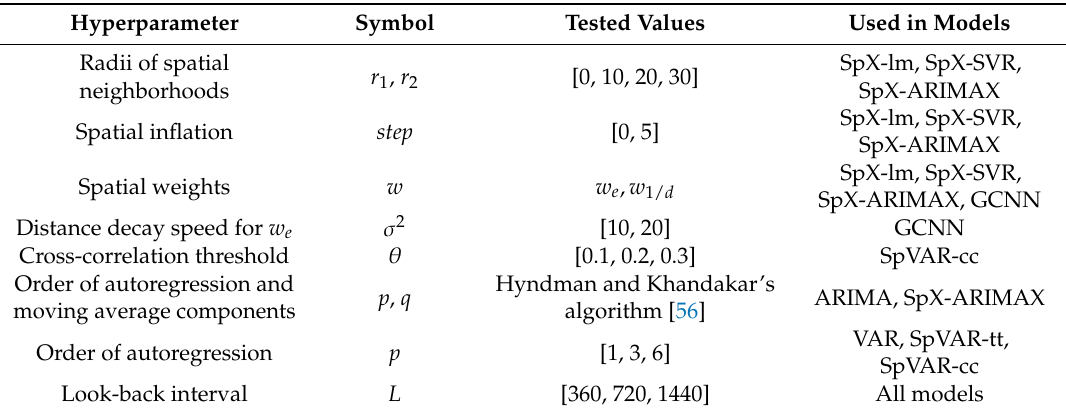
Table 2. Hyperparameter